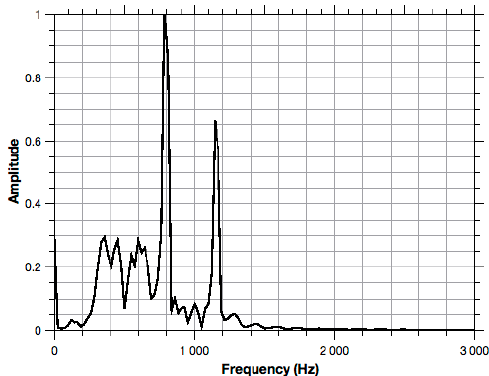
Figure 13. High-frequency oscillations. The scaling factor is equal to 10.6.